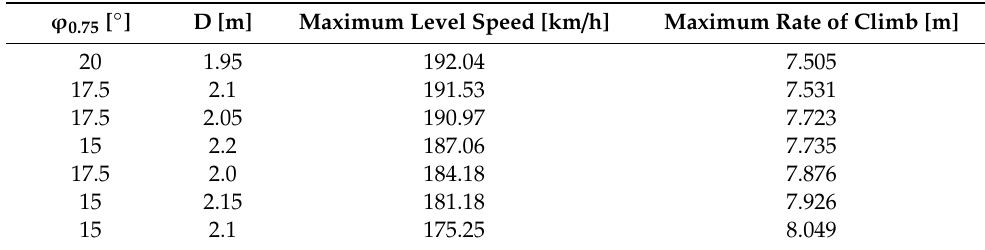
Table 4. Points on the Pareto front for maximum horizontal speed (cruise engine regime) and maximum rate of climb (see Figure 9).